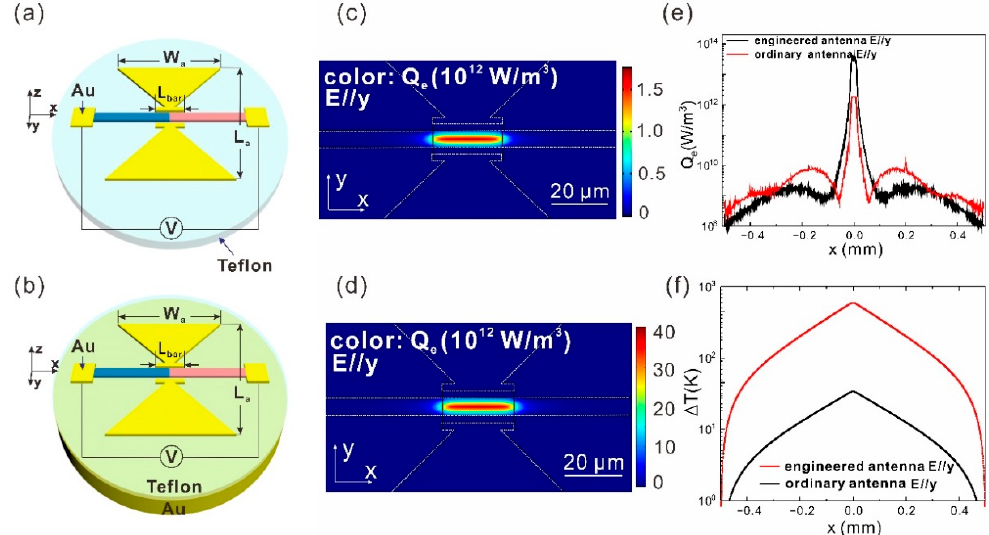
Figure 2. ( a ) Schematic of the ordinary antenna integrated aligned SWCNT film. L a = W a = 150 µ m, L bar = 20 µ m. ( b ) Schematic of the engineered antenna integrated aligned SWCNT film. A gold plane is added under the teflon layer. L a = W a = 171 µ m, L bar = 20 µ m. ( c ) Distribution of Q e on the x - y section at z = 1 µ m, cutting through the center of the ordinary antenna integrated aligned SWCNT film. ( d ) Distribution of Q e in the same way as ( c ) for the engineered antenna integrated aligned SWCNT film. ( e ) Q e varying along the x -axis at y = 0 µ m and z = 1 µ m through the center of the SWCNT film for the ordinary antenna integrated device (red line) and the engineered antenna integrated device (black line). ( f ) ∆ T varying along the x -axis at y = 0 µ m and z = 1 µ m through the center of the SWCNT film for the ordinary antenna integrated device (red line) and the engineered antenna integrated device (black line). In this figure, the incident light is polarized in the y -direction.